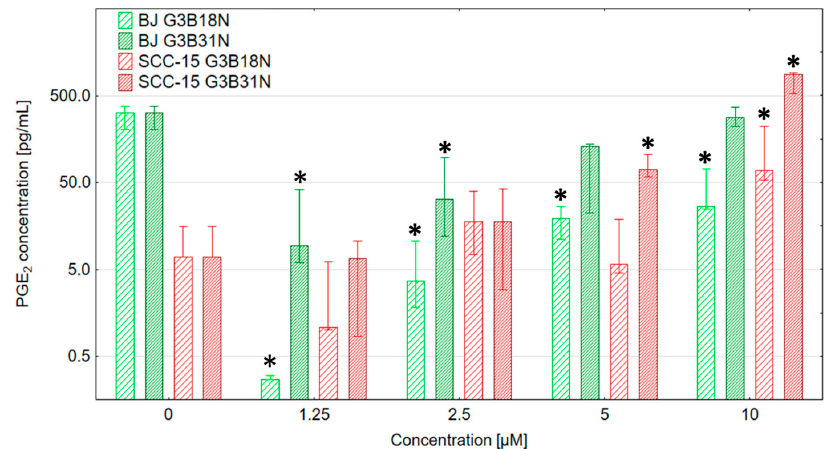
Figure 7. PGE 2 production by BJ and SCC-15 cells treated with G3 B18N or G3 B31N for 24 h estimated by ELISA. Bars show medians, whiskers are lower and upper quartile. * p < 0.05 significant difference against control (Kruskal-Wallis test).